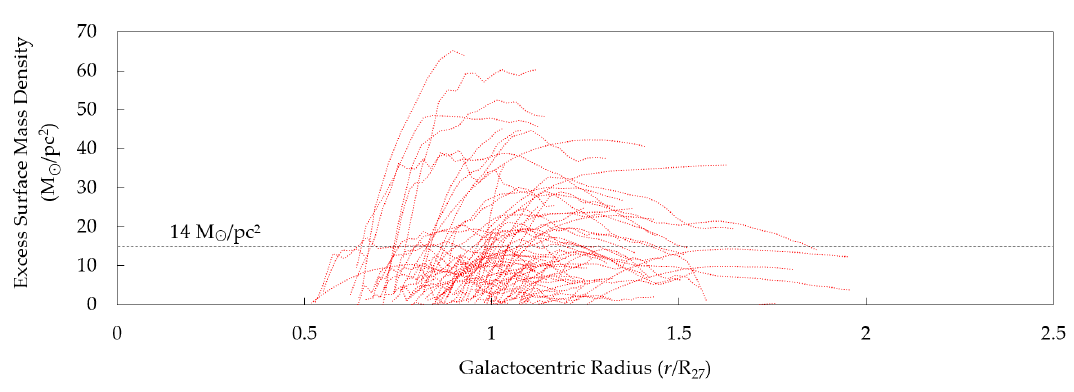
Figure 7. Superimposed excess density profiles are shown as red thin curves for 82 galaxies whose radial M / L profile cannot be fully explained by radially declining star mass gradient; 14 M (cid:12) / pc 2 is the mean average of all Σ ex ( r ) datapoints. The X-axis is a galactocentric radius in units of r / R 27 .